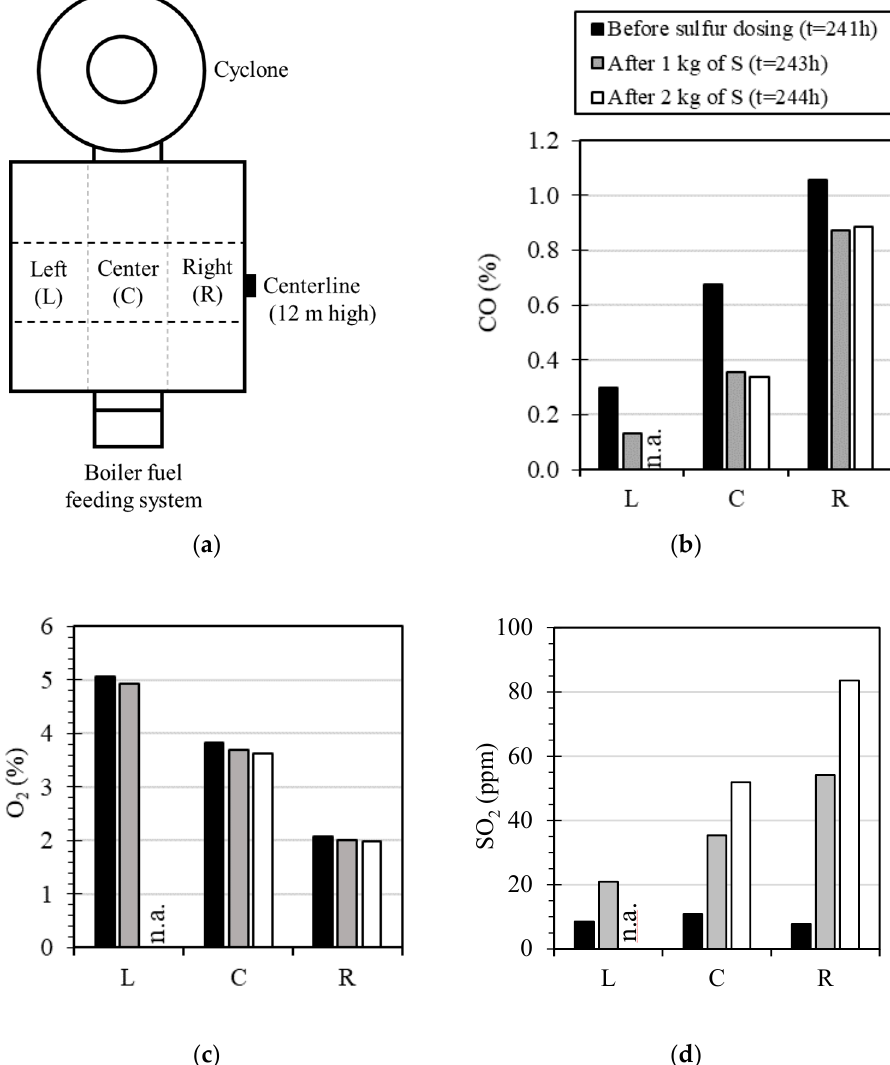
Figure 9. Measurements over the cross-section of the riser of the combustor at a height of 12 m from the fluidization nozzles before and during the addition of sulfur granulates to the boiler bed. ( a ) Schematic of the cross-section and locations of the measurement points in the centerline; ( b ) CO concentration (%vol); ( c ) O 2 concentration (%vol); and ( d ) SO 2 concentration (%vol). The term “n.a.” indicates that the measurement was not available.